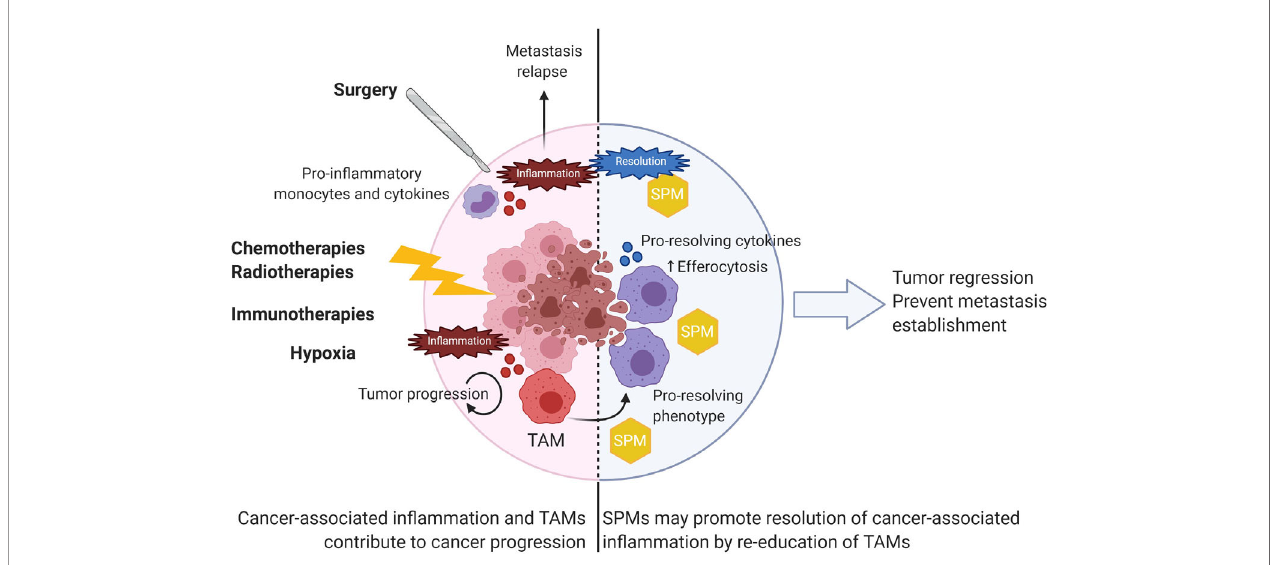
FIGURE 4 | SPMs as anticancer agents to resolve cancer-associated in fl ammation. Various extrinsic factors such as surgery and anticancer treatments as well as intrinsic hypoxia contribute to local in fl ammation within tumors. TAMs largely contribute to fuel tumor progression by various functions described in Figure 3 . Use of SPM would resolve cancer-associated in fl ammation by repolarizing TAMs toward a pro-resolving phenotype with increased efferocytosis capabilities. As a result, SPMs could induce tumor regression and prevent further metastasis